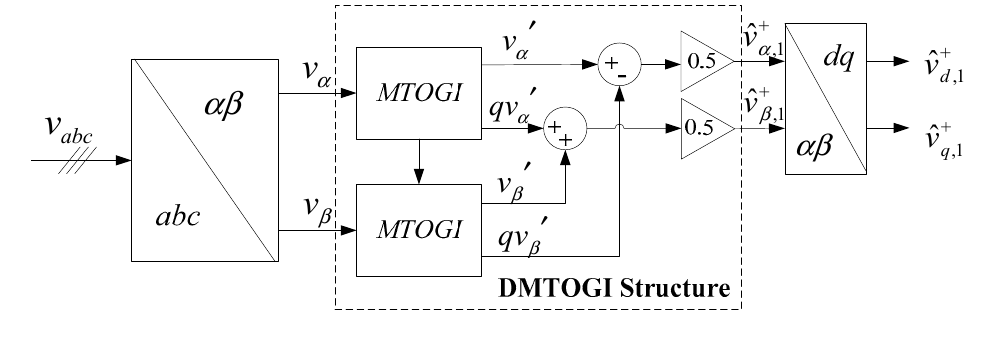
Figure 3. Block diagram of DMTOGI.